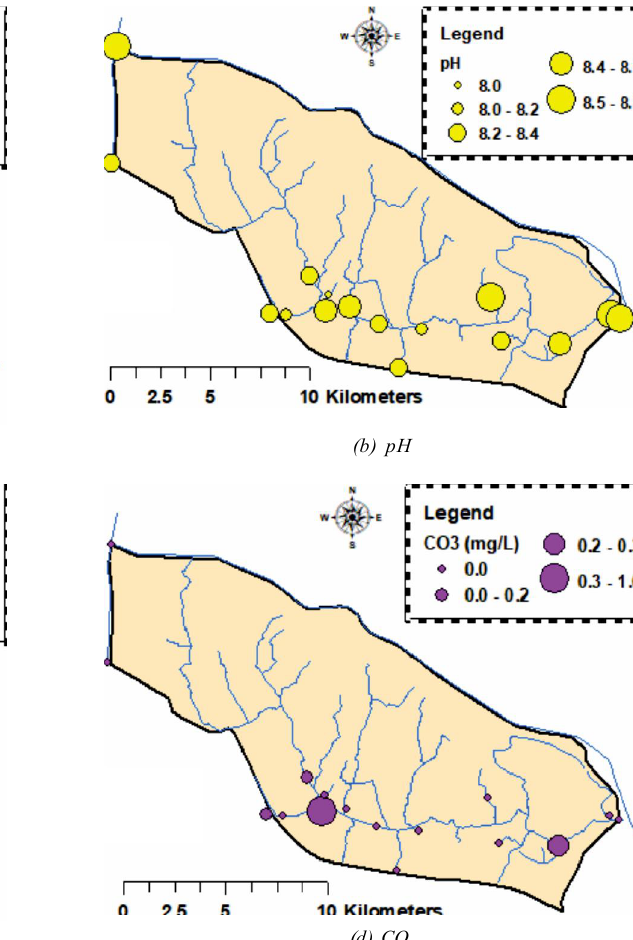
, SAR, AND CO FOR WATER SAMPLES COLLECTED FROM STUDY W 3